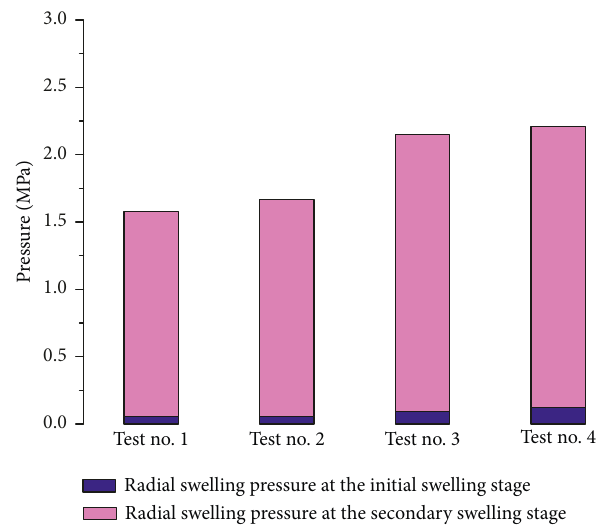
Figure 5: Radial swelling pressures produced at different swelling